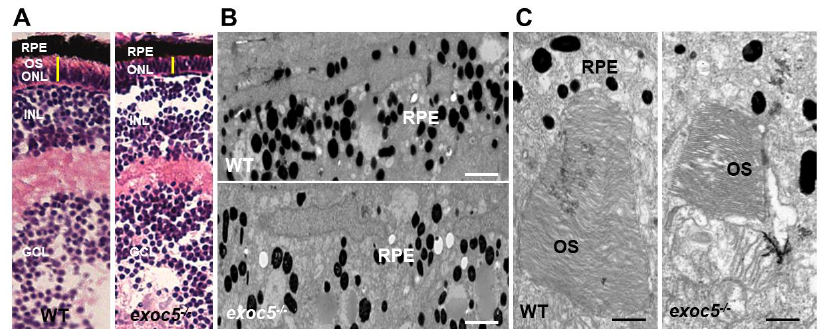
Figure 1. Histological and TEM analysis of RPE and retinas of wild-type and exoc5 mutant zebrafish larvae. ( A ) In systemic exoc5 homozygous mutants ( exoc5 − / − ), the photoreceptor outer segments (OS) were shorter compared to wild-type (WT) siblings. ( B ) Ultrastructural analysis of WT and exoc5 −/− mutant RPE using transmission electron microscopy indicate reduced levels of melanosomes in the mutant fish RPE. ( C ) WT photoreceptors showed tightly stacked disk membranes, while in exoc5 −/− mutants, only remnants of outer segments (OS) could be observed. Please note the apparent formation of ectosomes at the base of the mutant photoreceptor OS. Scale bars = 2 μ m ( B ), 800 nm ( C ). OS, outer segments; ONL, outer nuclear layer; RPE, retinal pigmented epithelium; INL, inner nuclear layer; GCL, ganglion cell layer.